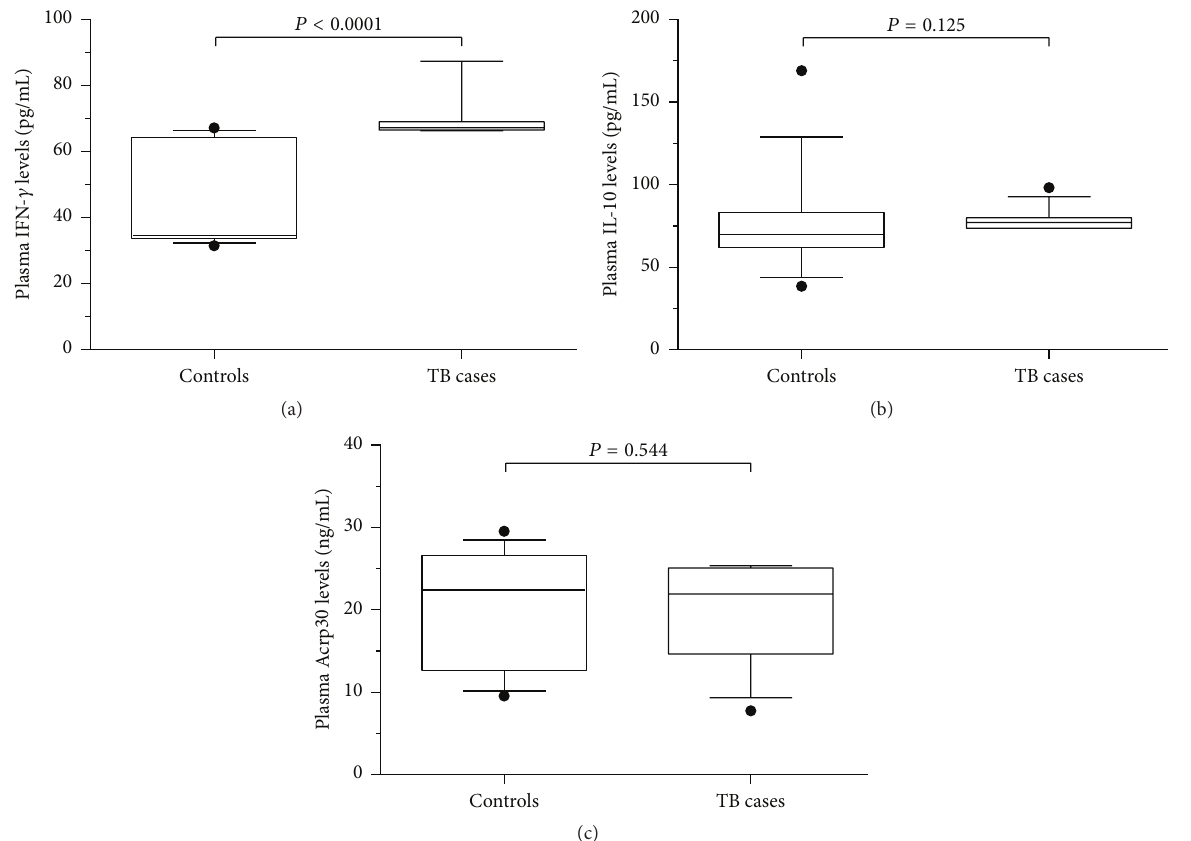
Figure 1: Circulating cytokine levels in new tuberculosis (TB) cases ( 𝑛 = 13 ) and controls ( 𝑛 = 14 ). (a) Circulating interferon-gamma (IFN- 𝛾 ) levels in TB cases and controls. (b) Circulating interleukin-10 (IL-10) levels in TB cases and controls. (c) Circulating adiponectin (Acrp30) levels in TB cases and controls. Data are presented as box plots, where the box represents the interquartile range, the line through the box represents the median, whiskers indicate the 10th and 90th percentiles, and the closed circles represent outliers. Statistical comparisons were performed using the Mann-Whitney 𝑈 test. IFN- 𝛾 levels (pg/mL) were elevated in TB cases compared to controls ( 𝑃 < 0.0001 ). IL-10 (pg/mL; 𝑃 = 0.125 ) and adiponectin (ng/mL; 𝑃 = 0.544 ) levels were similar between the TB cases and